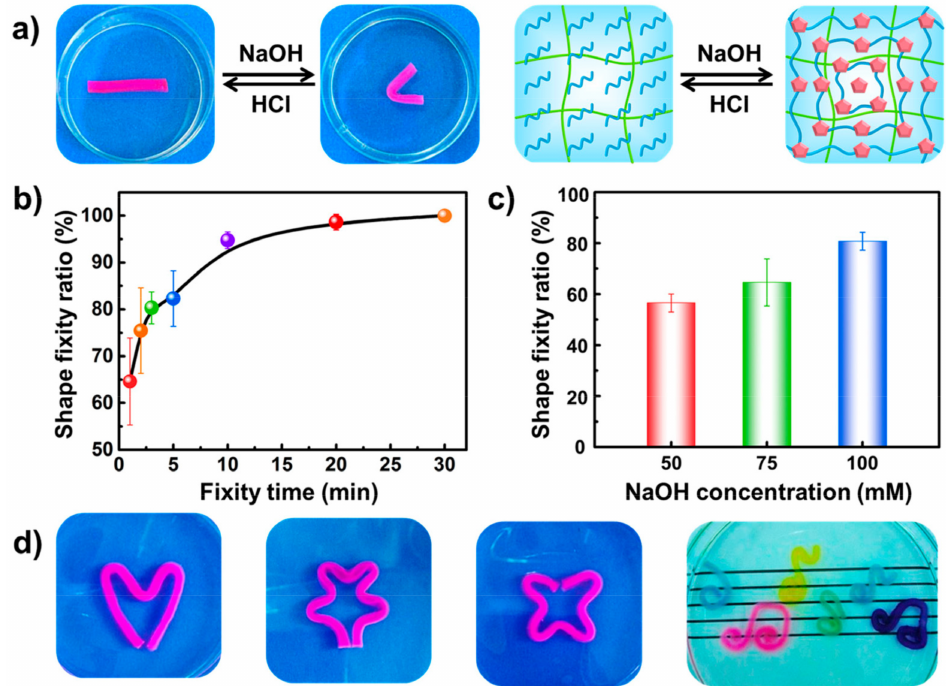
Figure 11. ( a ) The shape memory performance and mechanism founded on chitosan physical microcrystalline crosslink. ( b ) Change in the shape fixity ratios of the PAAm-CS hydrogels as a function of the fixity time in NaOH solution (75 mM). ( c ) Change in the shape fixity ratios as a function of concentration of NaOH solution with a shape fixity time of 1 min. ( d ) Pictures of the more complex transient shapes of PAAm-CS hydrogel secured by NaOH (75 mM). Reprinted with permission from reference [84], Copyright 2017 by the authors and license MDPI, Basel,